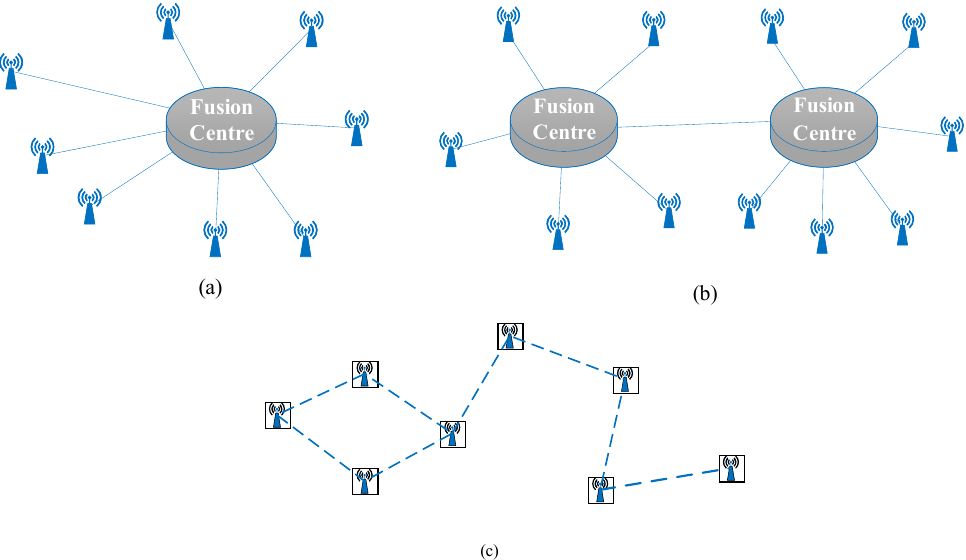
Figure 4. ( a ) Centralized fusion, ( b ) hierarchical fusion, and ( c ) decentralized fusion architectures.